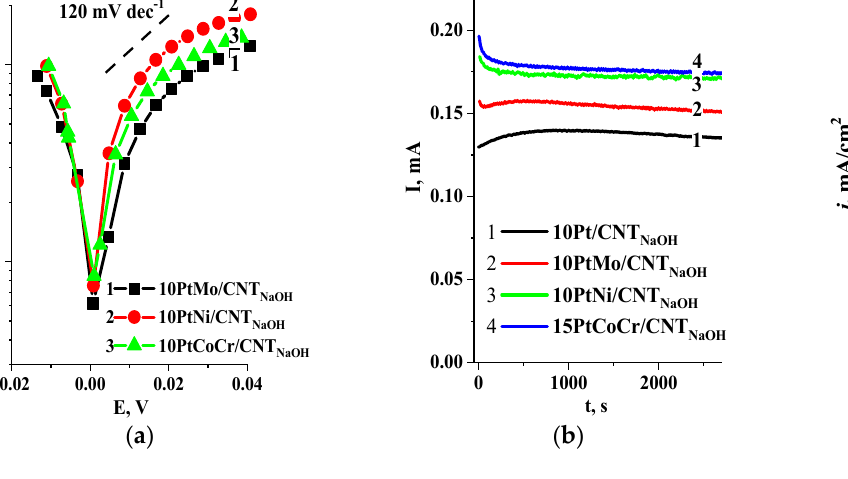
Figure 4. ( a ) Polarization curves in Tafel coordinates for platinum-modified materials (indicated in Figure), O 2 , 0.1 M KOH, 5 mV/s, 1500 rpm; ( b ) Chronoamperometric measurements at 0.4 V, 650 rpm; ( c ) Limiting current as a function of electrode rotation speed.